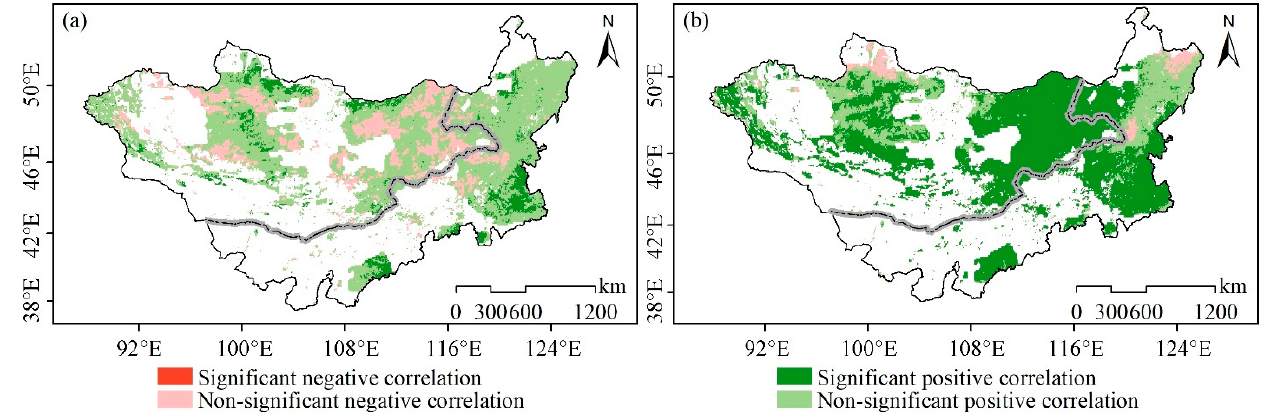
Figure 10. Significance of the partial correlation between ANPP and temperature ( a ), and precipitation ( b ), excluding the area affected by human activities.